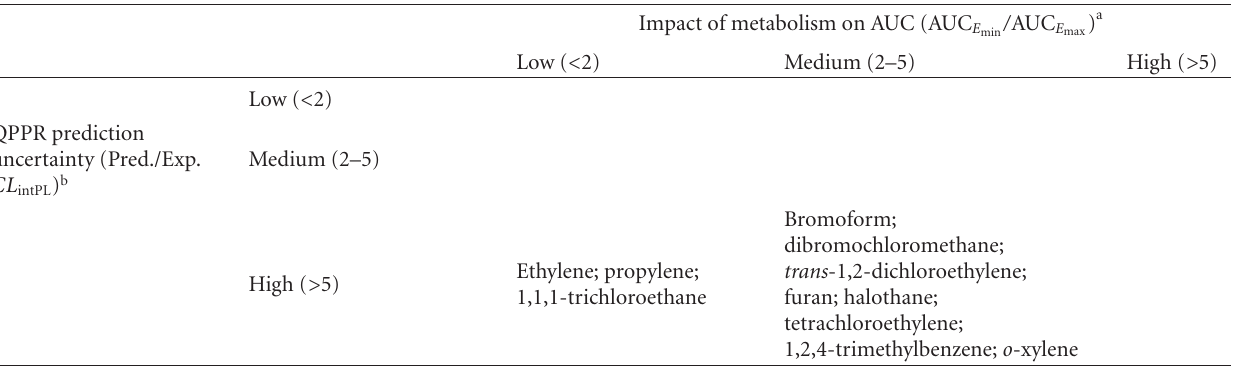
Table 7: Reliability analysis for the chemicals in the QPPR evaluation